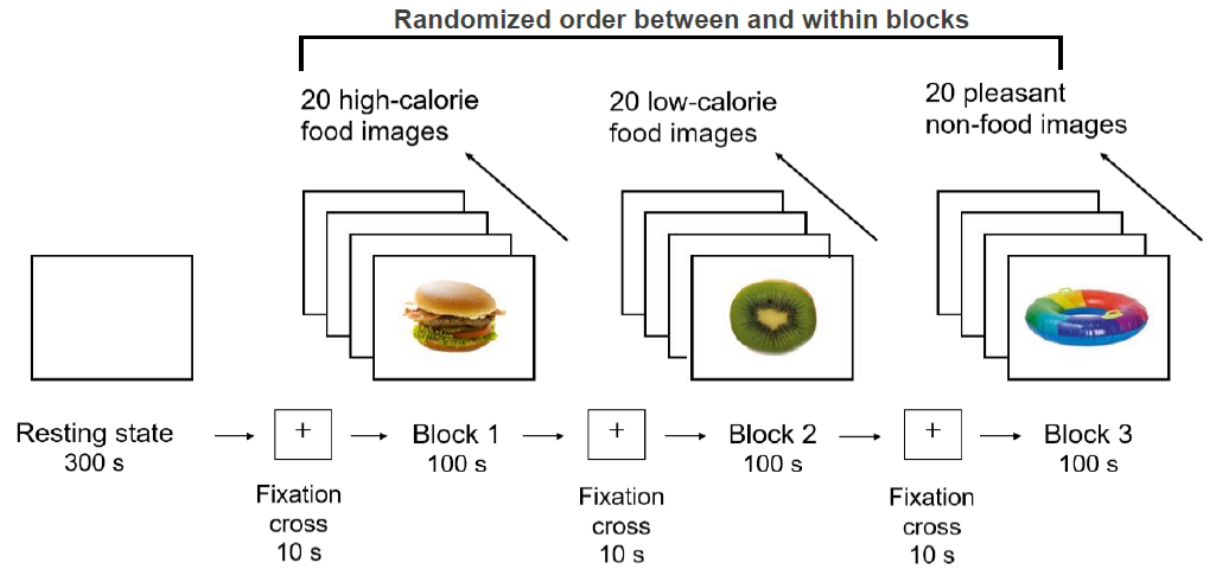
Figure 1. Design of the experimental procedure. After resting-state electroencephalography, three blocks of high-calorie, low-calorie, and pleasant non-food stimuli were presented in a randomized order on the screen. Images were randomly presented within a block and shown for 5 s each, adding up to 100 s per stimulus block.